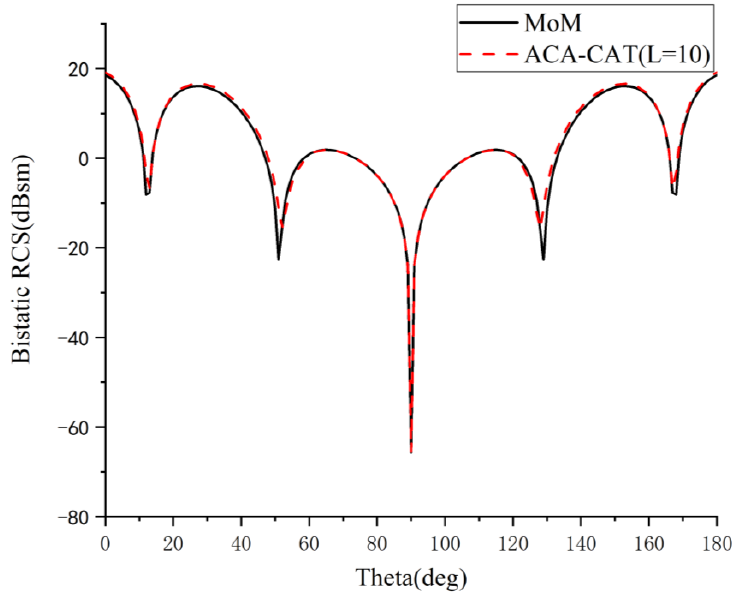
Figure 7. Bistatic RCS for a four-patch array model using MoM and ACA-CAT of the non-Gaussian sampling points.